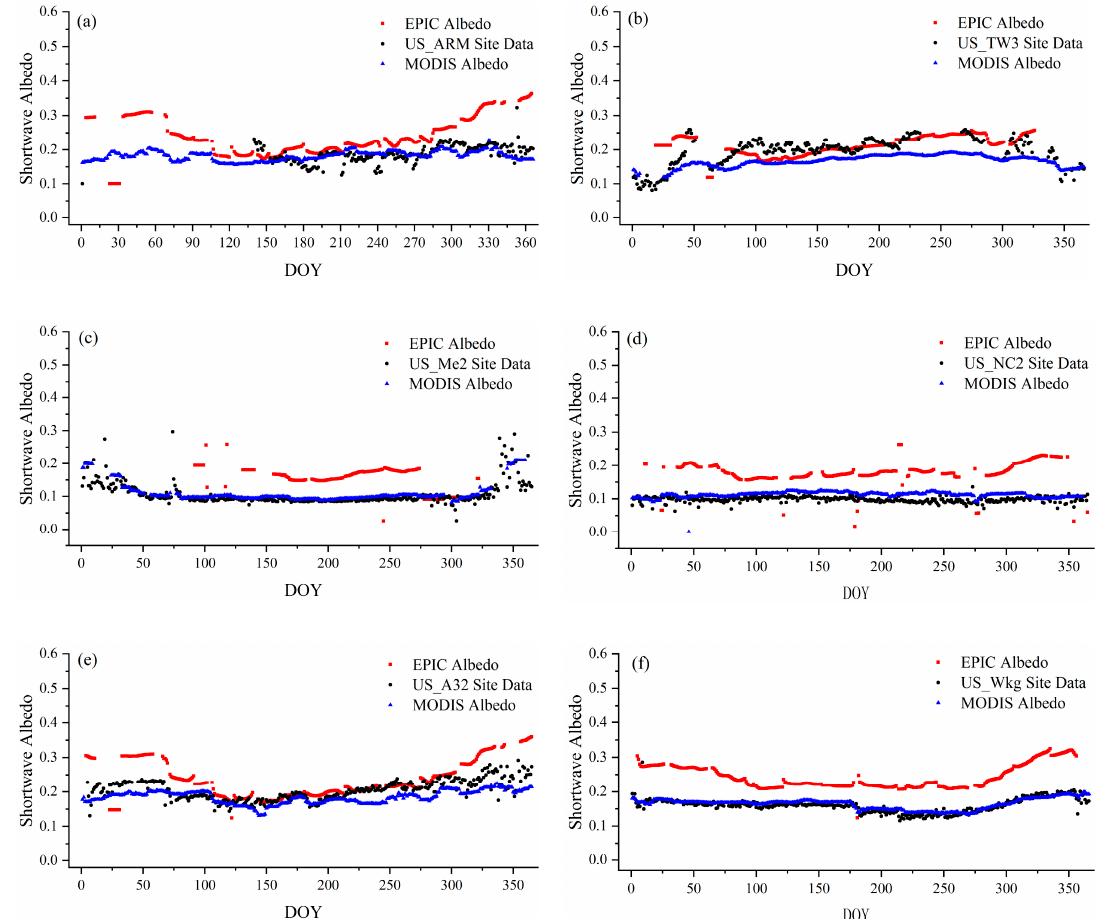
Figure 3. Daily averaged shortwave black-sky albedo from EPIC on 4 June, 2016 in the study area. 0 represents the area without value because of inversion failure caused by clouds,